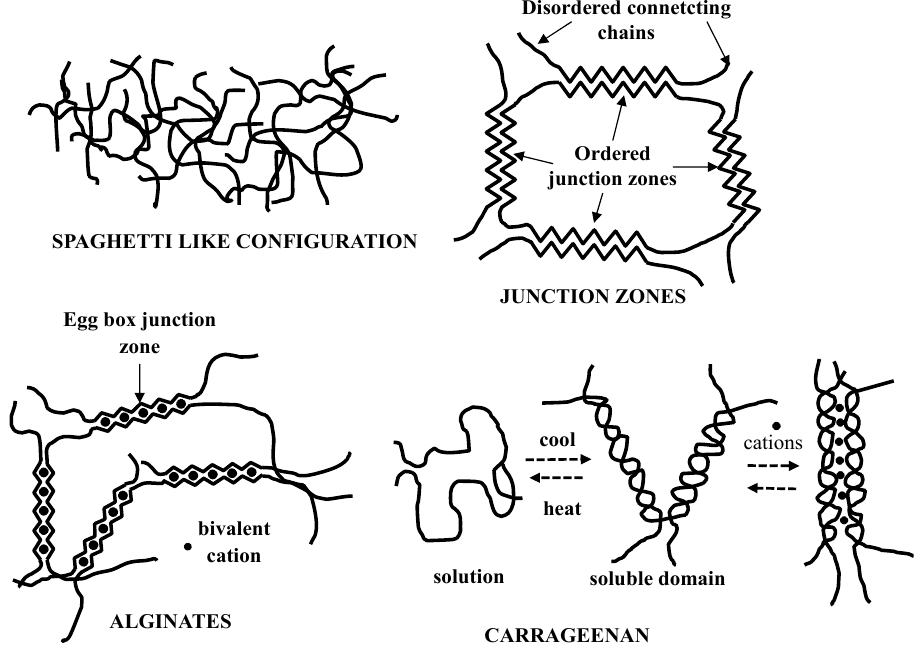
Figure 4. Structures occurring in physically cross-linked polysaccharides